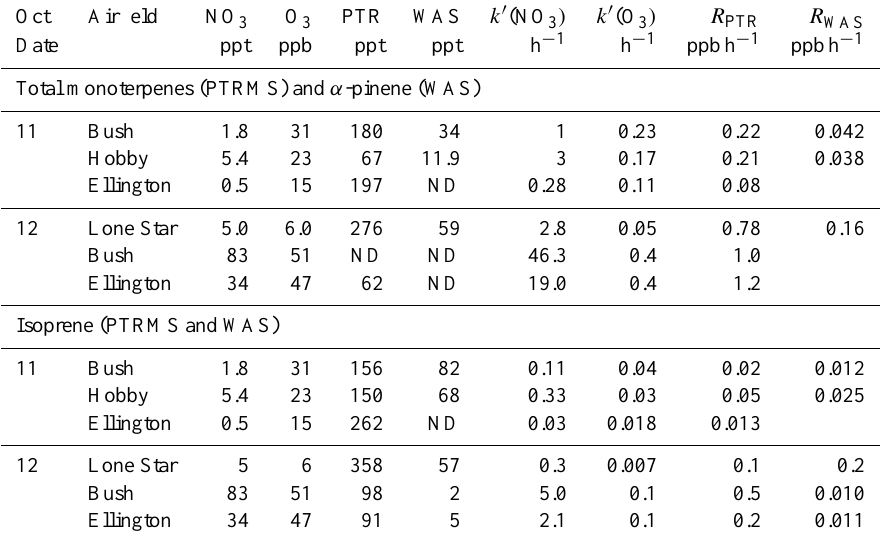
Table 2. Biogenic VOC, NO 3 and O 3 mixing ratios, first-order VOC loss rate coefficients with respect to both NO 3 and O 3 ( k 0 (NO 3 ) , k 0 (O 3 )) , and total VOC loss rates within the nocturnal boundary layer for six airfield approaches on 11 October and 12 October. The VOC mixing ratios are shown for both PTR and WAS samples, where WAS monoterpenes refers to α -pinene alone. Oxidation rates are calculated for the mixing ratios determined for each instrument ( R PTR , R WAS )